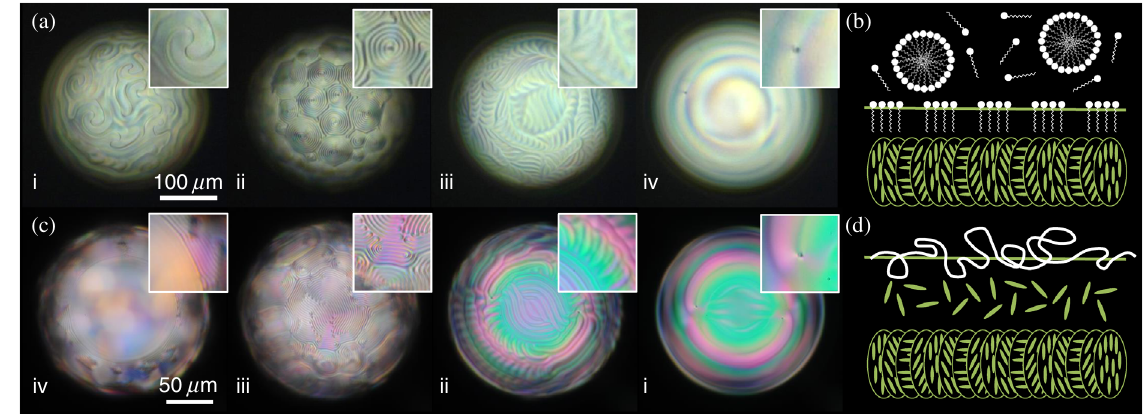
FIG. 1. Stripe patterns emerge on a CLC shell as the anchoring is changed from homeotropic to planar. Throughout, the pitch is 5 μ m (2.8% CB15). (a) Time series of a CLC shell losing surfactant from its interface from (i) to (iv) (see Video 1 in Ref. [32]). As the surfactant surface concentration is diluted from 10 mM SDS with time, the homeotropic anchoring strength weakens. Four distinct patterns, from strongest to weakest homeotropic anchoring, are identifiable: subsurface defect lines (i), double-spiral domains (ii), thick planar stripes (iii), and planar anchoring (iv). (b) Schematic of surfactants on the CLC-water interface. The surfactant tails cause the CLC molecules to prefer perpendicular alignment to the interface. (c) Time series of a heated CLC shell, with temperature increasing from (i) to (iv) (see Video 2 in Ref. [32]). A few tenths of degrees below the clearing point, an isotropic layer nucleates at the CLC-water interface, inducing weak out-of-plane anchoring of the remaining CLC. As temperature is increased, the isotropic layer grows inwards, confining the remaining CLC until the entire thickness turns isotropic. Four patterns are also identified: planar anchoring (i), thick planar stripes (ii), thin stripes (iii), and (iv) complete untwisting. (d) Schematic of the isotropic layer growing between the bulk CLC and the PVA-stabilized interface between water and liquid crystal. The radius ( R ) and thickness ( h ) of the shells are R ∼ 150 μ m and h ∼ 50 μ m in (a) and R ∼ 75 μ m and h ∼ 15 μ m in